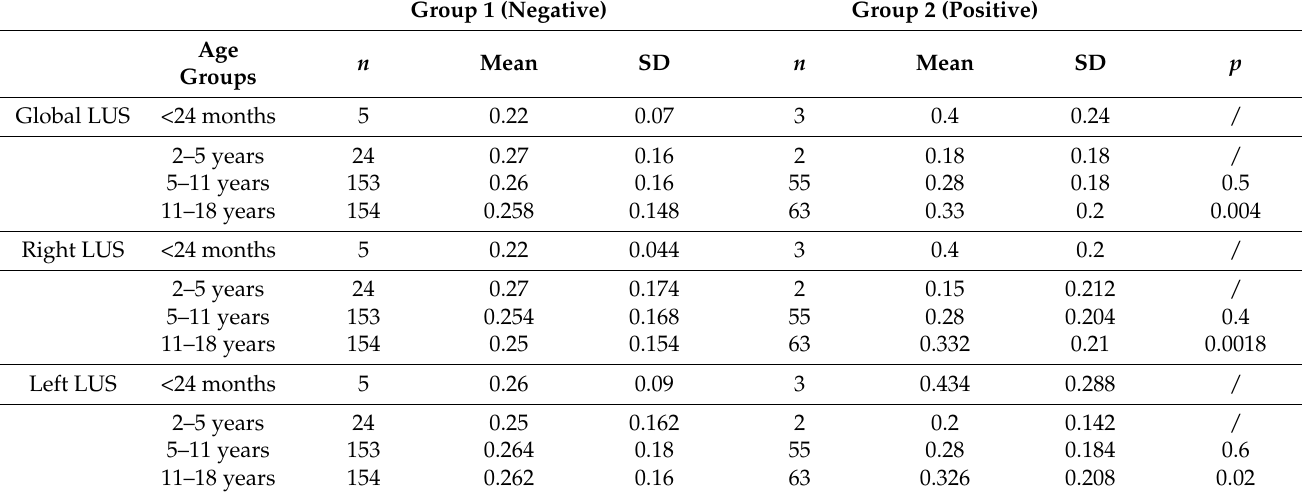
Table A3. Mean and standard deviation (SD) of right and left LUS in patients with positive and negative anamnesis for COVID-19, divided into four age groups.